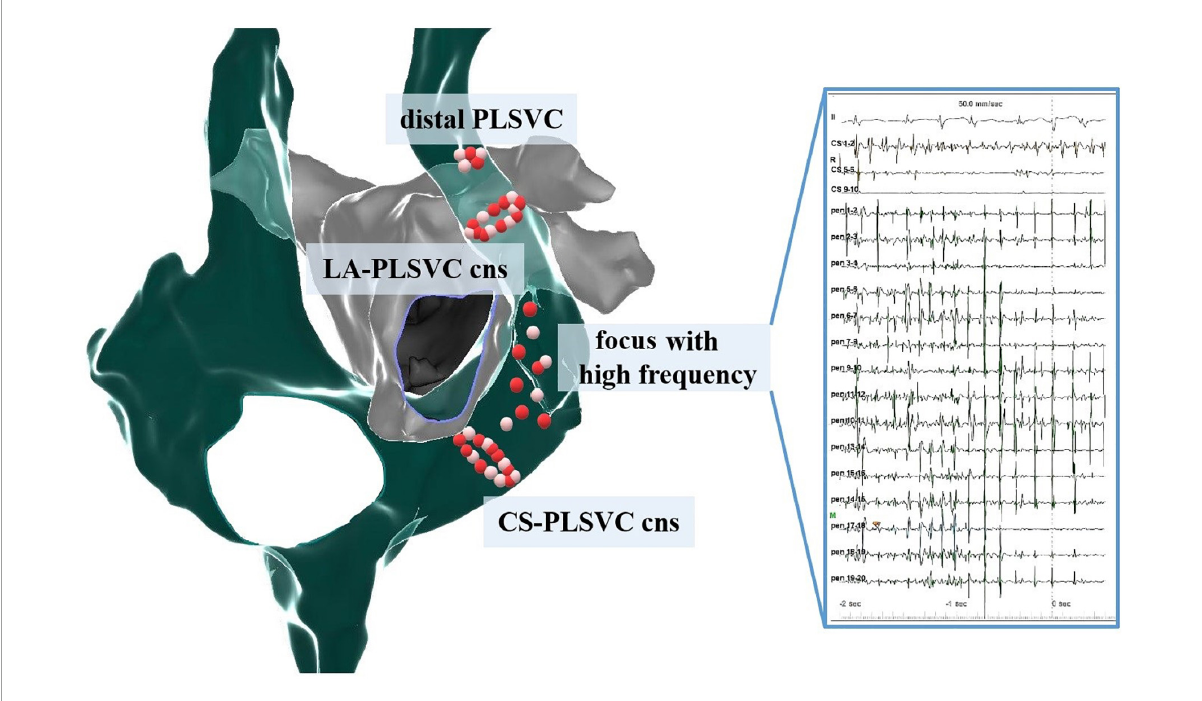
FIGURE6 Distribution pattern of ablation sites within PLSVC. Cns, connections; LA, left atrium; CS, coronary sinus.